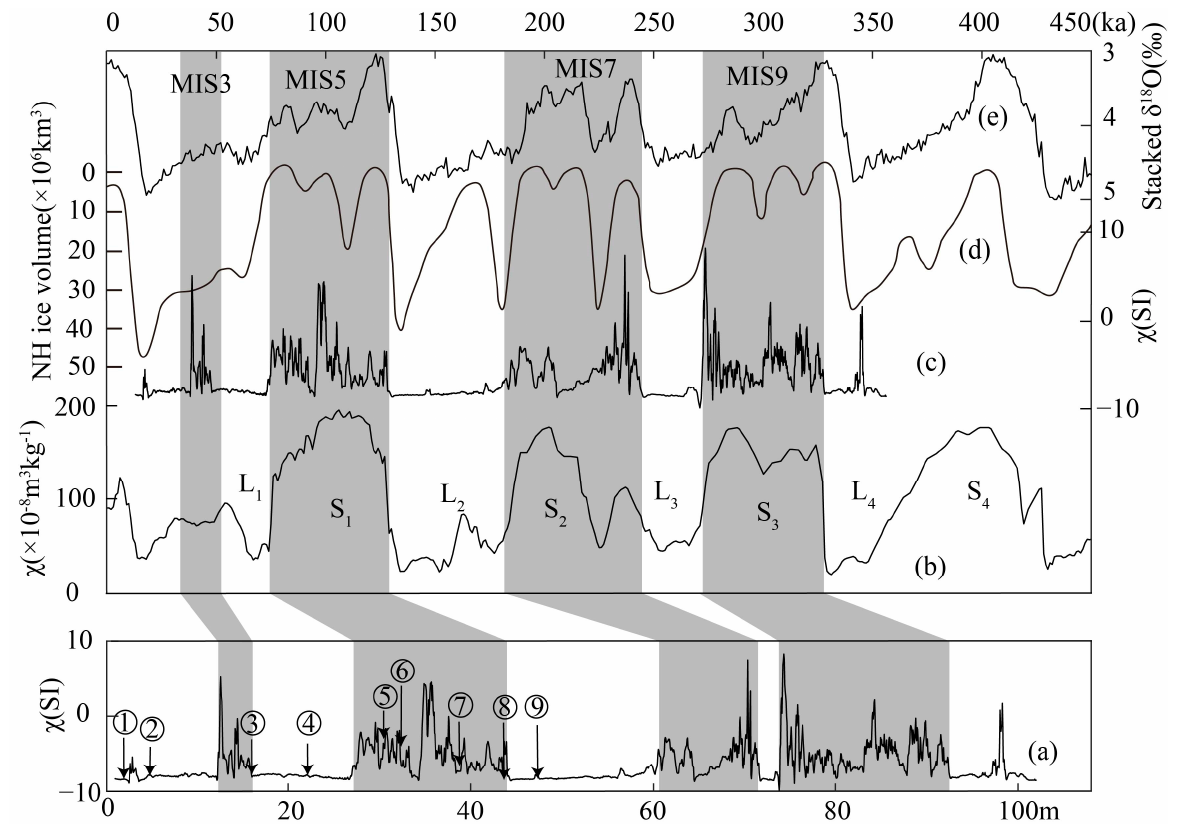
Figure 6. Linkage between MS of the SHBZK-1 core and different targets; ( a ) MS of the SHBZK-1 core in depth domain ( 1 (cid:13) – 9 (cid:13) are the OSL ages of Table 1); ( b ) MS of Luochuan section from [4,8]; ( c ) MS of the SHBZK-1 core in time domain; ( d ) the Northern Hemisphere (NH) ice volume [61]; ( e ) the stacked benthic δ 18 O record